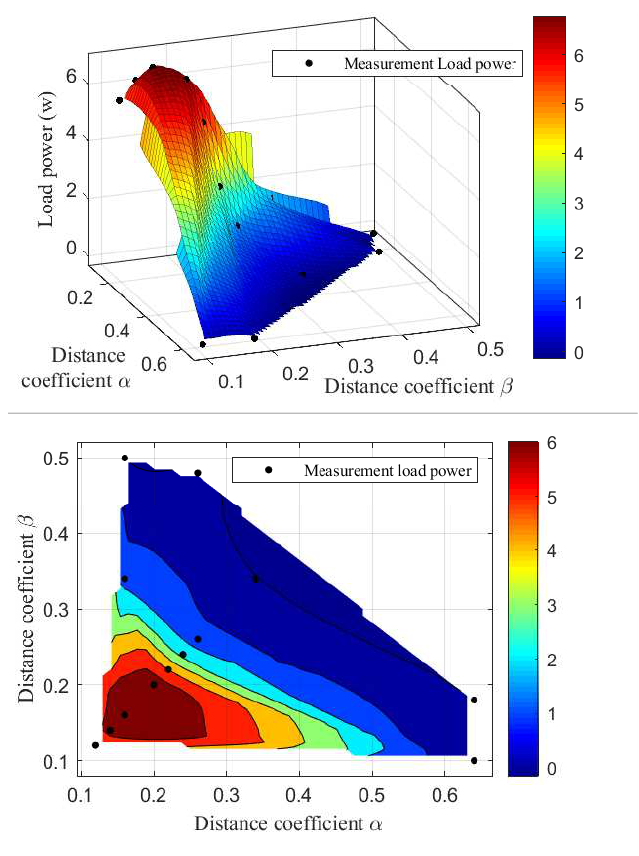
Figure 15. Relationship between transfer power and the distance coefficient α , β of the two-intermediate coil MCR-WPT